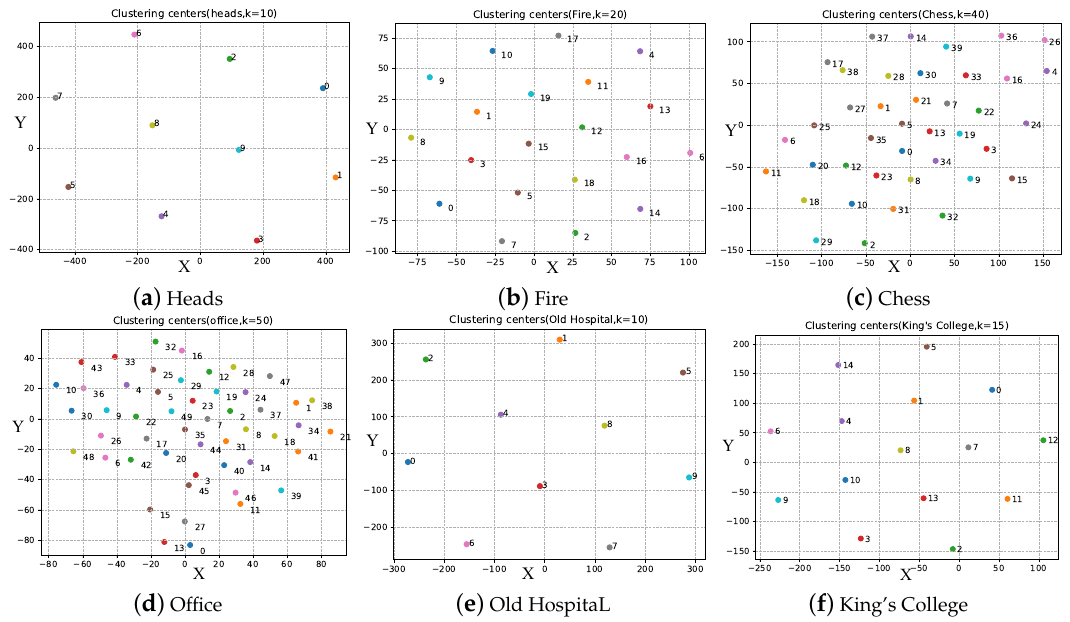
Figure 6. Visualization of clustering centers (after dimensional reduction by t-SNE). We can see that the clustering centers are evenly distributed, showing the high effectiveness of clustering.